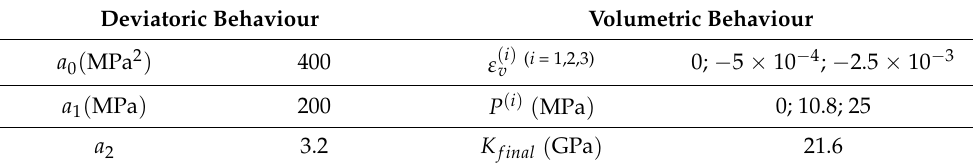
Table 5. Identification of the parameters of KST